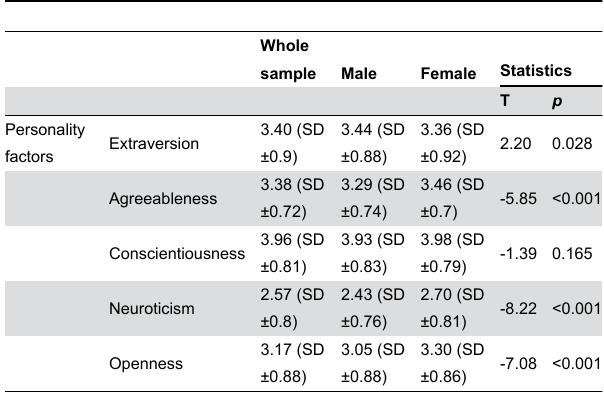
Table 3. Sex Differences in Personality factors.